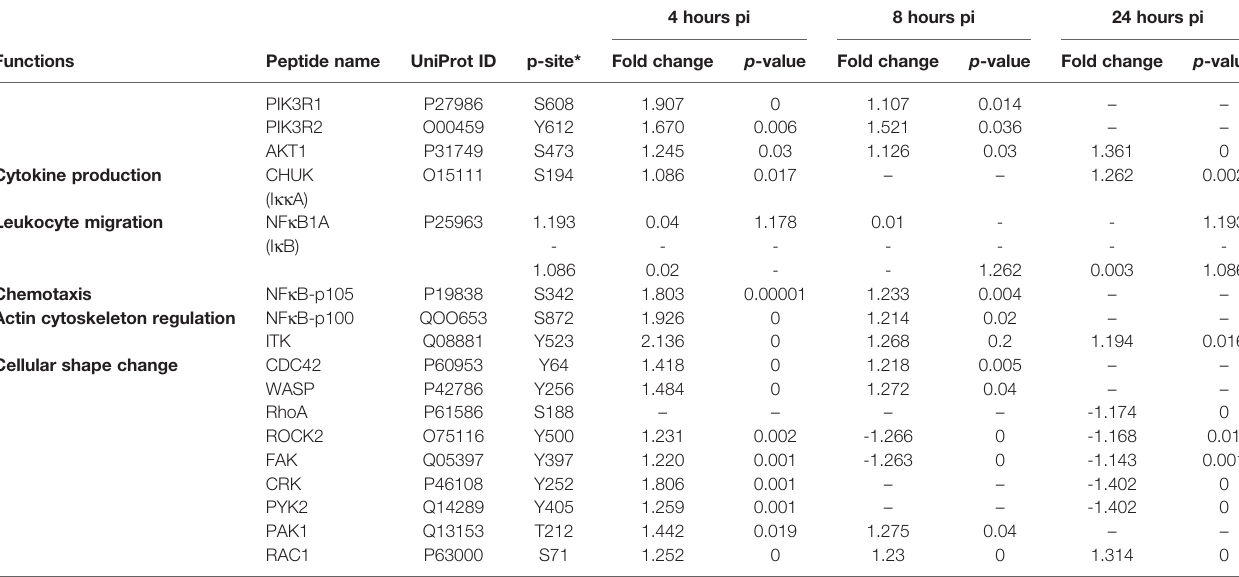
TABLE 6B | Members of the chemokine signaling pathway showing differential phosphorylation between Salmonella enterica serovar Enteritidis-infected cecal tissue and non-infected cecal tissue: PI3K signaling